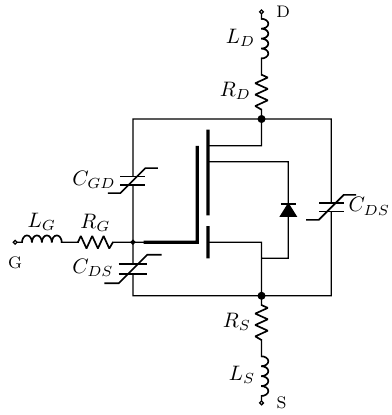
Figure 2. Equivalent circuit of GaN